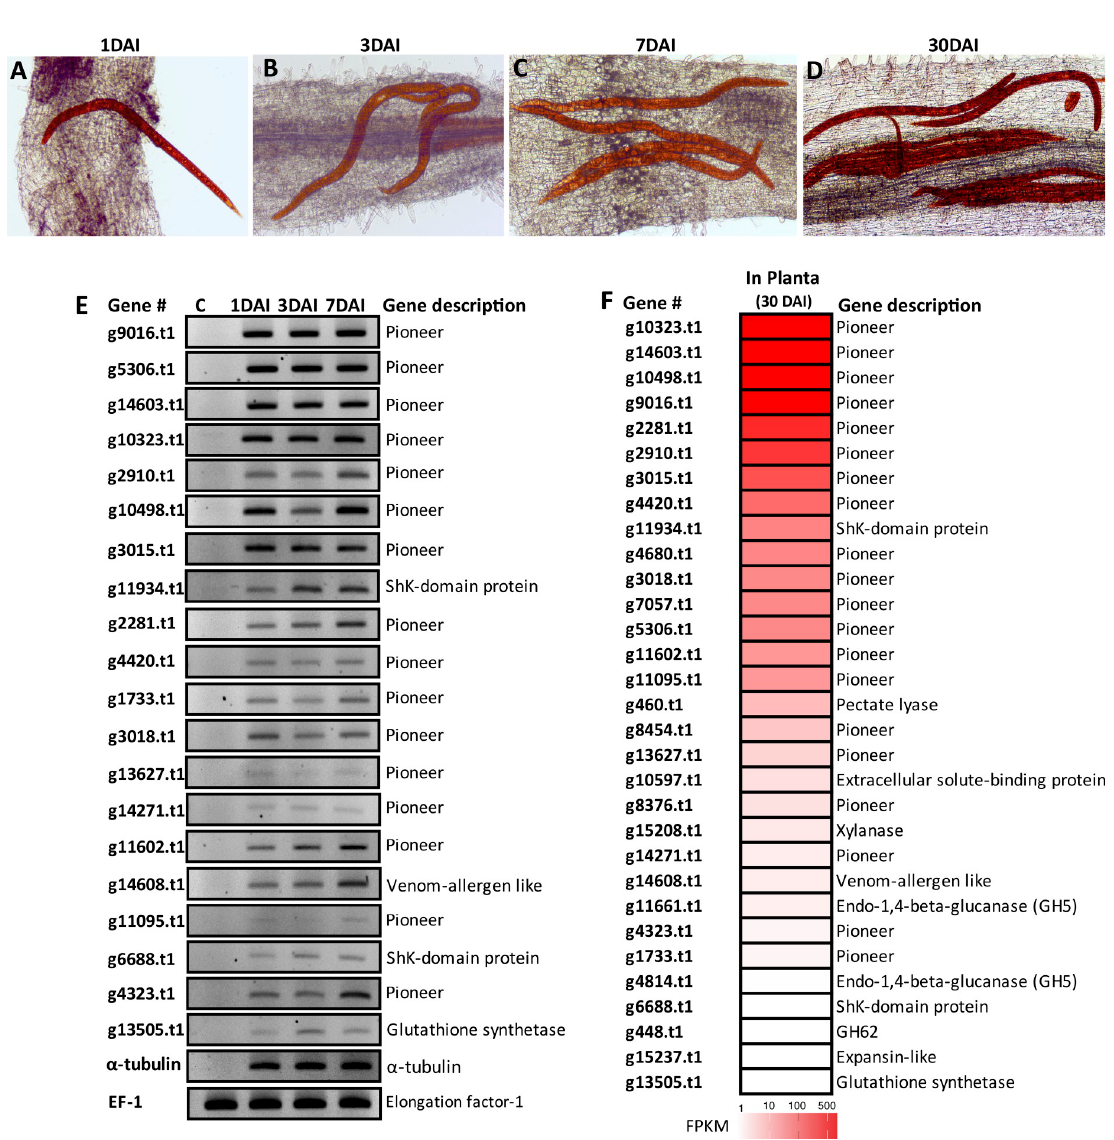
Fig 8. Expression profile of Radopholus similis candidate effector genes in planta . (A-D) Acid fuschin staining of nematodes (red color) in carrot hairy roots at 1 (A) , 3 (B) , 7 (C) and 30 (D) days after inoculation. (E) Semi-quantitative RT-PCR validating the expression of 20 candidate effectors in carrot hairy roots at 1, 3 and 7 DAI. As a positive control, all cDNA libraries were amplified with primers derived from the α -tubulin gene of R . similis or the translation elongation factor EF-1 alpha gene ( EF-1 α ) of carrot. C corresponds to non-infected carrot hairy roots. (F) Heat map representing the expression profile of 30 candidate effectors validated herein in the esophageal glands of R . similis . The expression levels were calculated using the fragment per kilobase of transcript per million mapped reads (FPKM) values of two independent RNA-seq libraries generated from mixed nematode stages collected from carrot hairy roots at 30DAI.